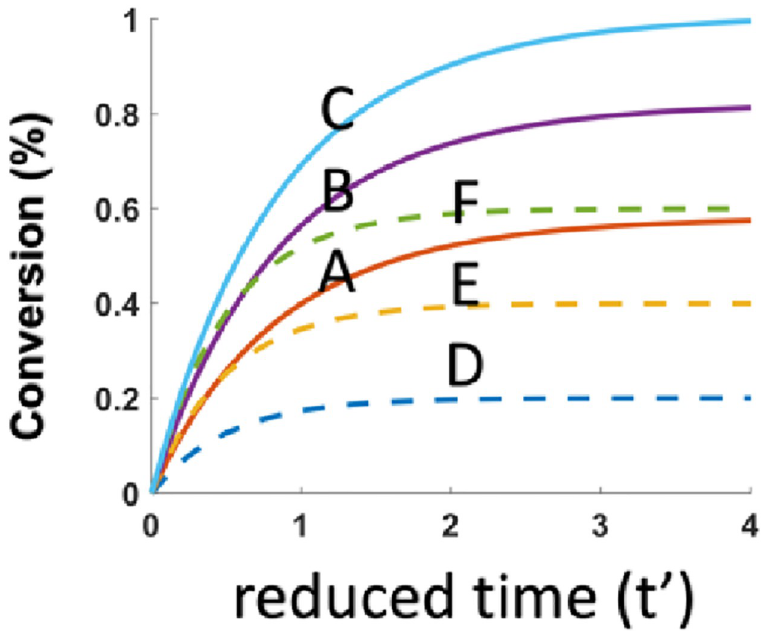
Fig 2. Efficacy of FRP and CP for various B 0 = (0.2, 0.4, 0.6), for Curve-A, B, C (for FRP); and Curve-D, E, F (for CP);for fixed b = 1.0 and N 0 = 1.0.